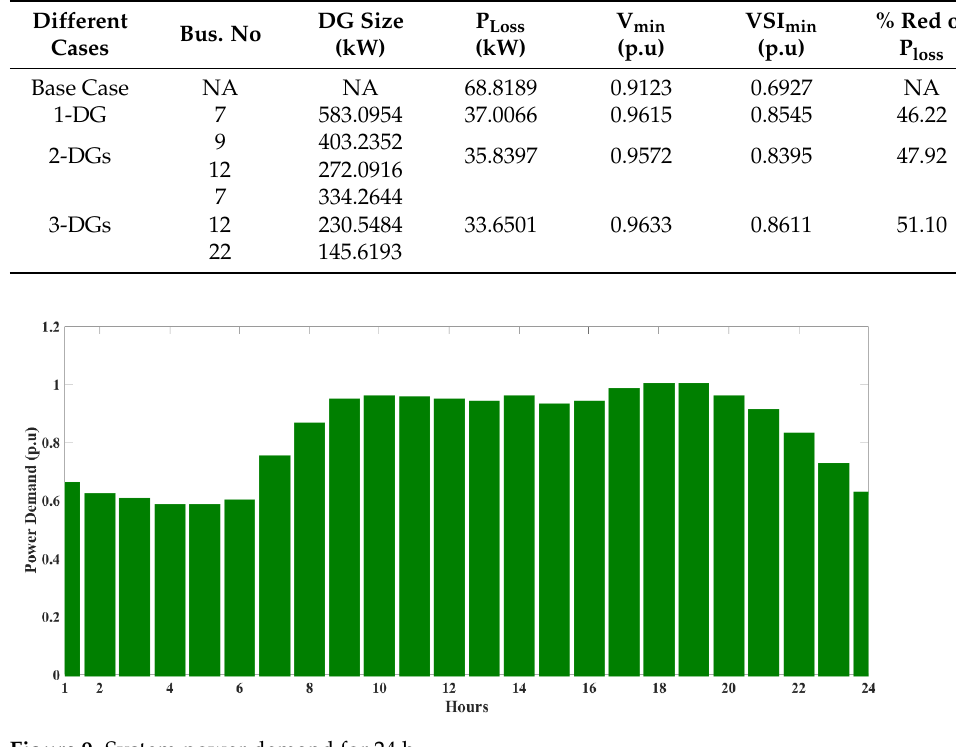
Figure 9. System power demand for 24 h. Table 2. Results for 28 Indian Real Test System considering different cases.